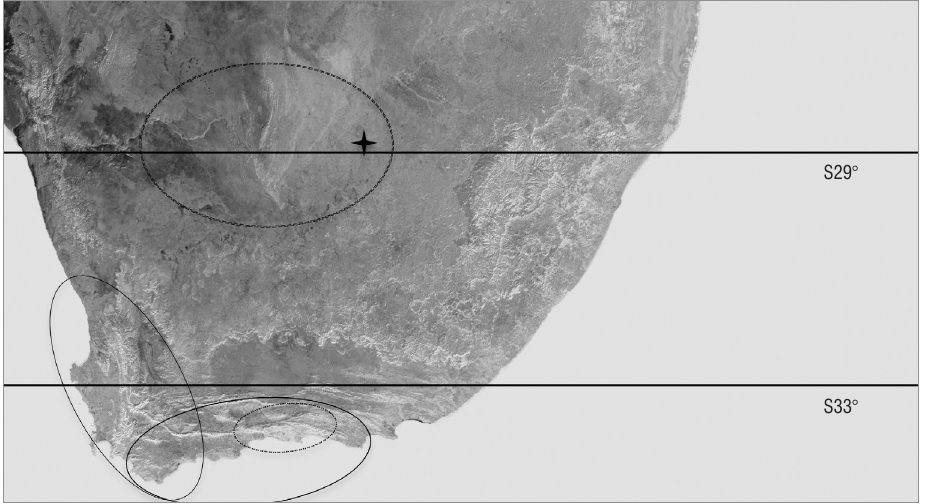
Figure 1: Map of southern Africa with forest, fynbos and lower Orange River Valley regions approximated. The fynbos region is indicated by the solid outline, the forest region by the small dotted outline and the lower Orange River Valley by the dashed outline. Black lines indicate approximate latitude markers and the star indicates the approximate location of